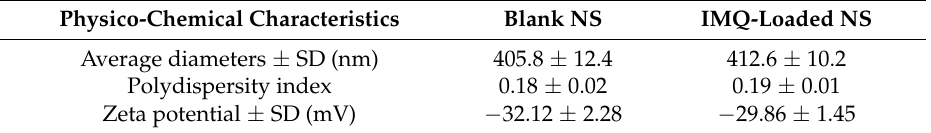
Table 2. Physico-chemical characteristics of blank and IMQ-loaded nanosponge (NS)